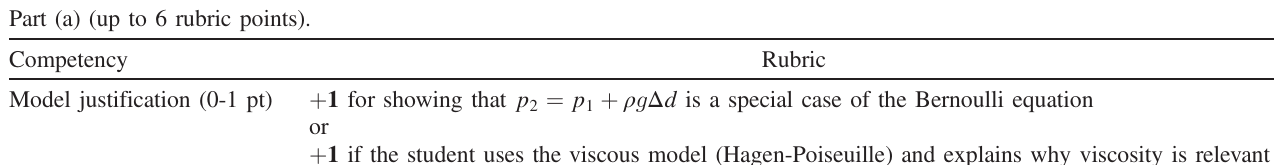
TABLE I. Fluids task code (competencies and rubrics), developed as described in text. Task presented in Figs. 1 – 3. Part (a) (up to 6 rubric